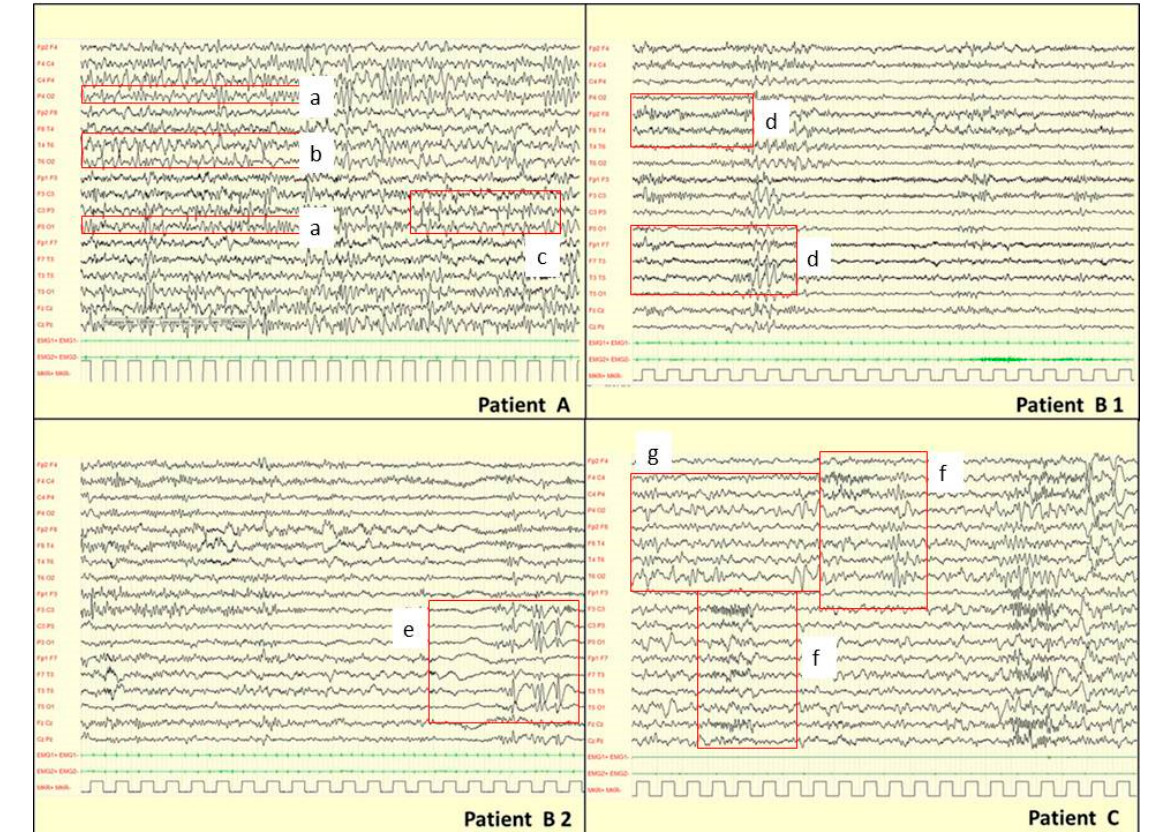
Figure 1. EEG findings in TUBA1A , TUBB2 and TUBB3 genes mutations. Patient A [P89815] (33 months) has a mutation in TUBA1A gene and at MRI multifocal PMG. During drowsiness: